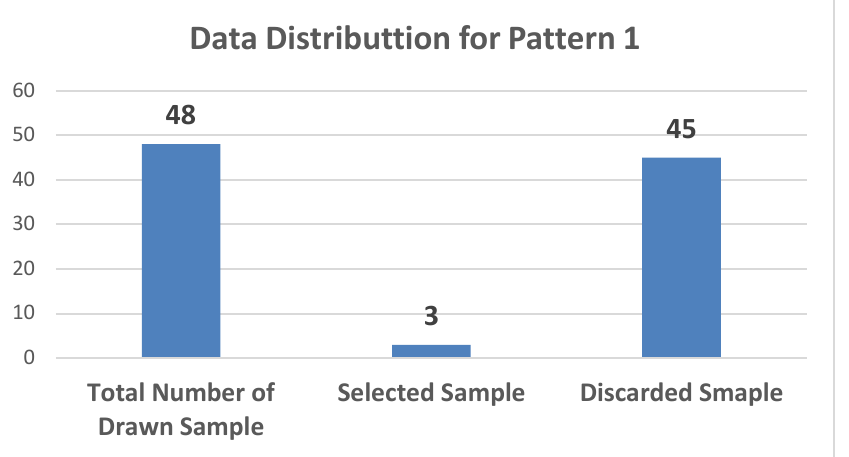
Figure 1: Data Distribution for Pattern